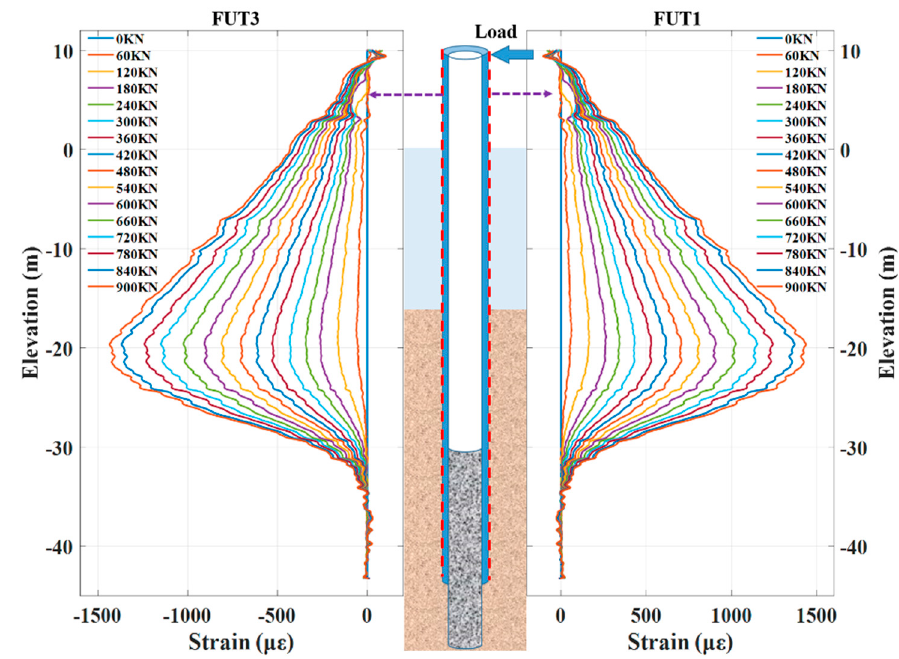
Figure 6. Strain values of the corresponding elevation from 0 kN to 900 kN.